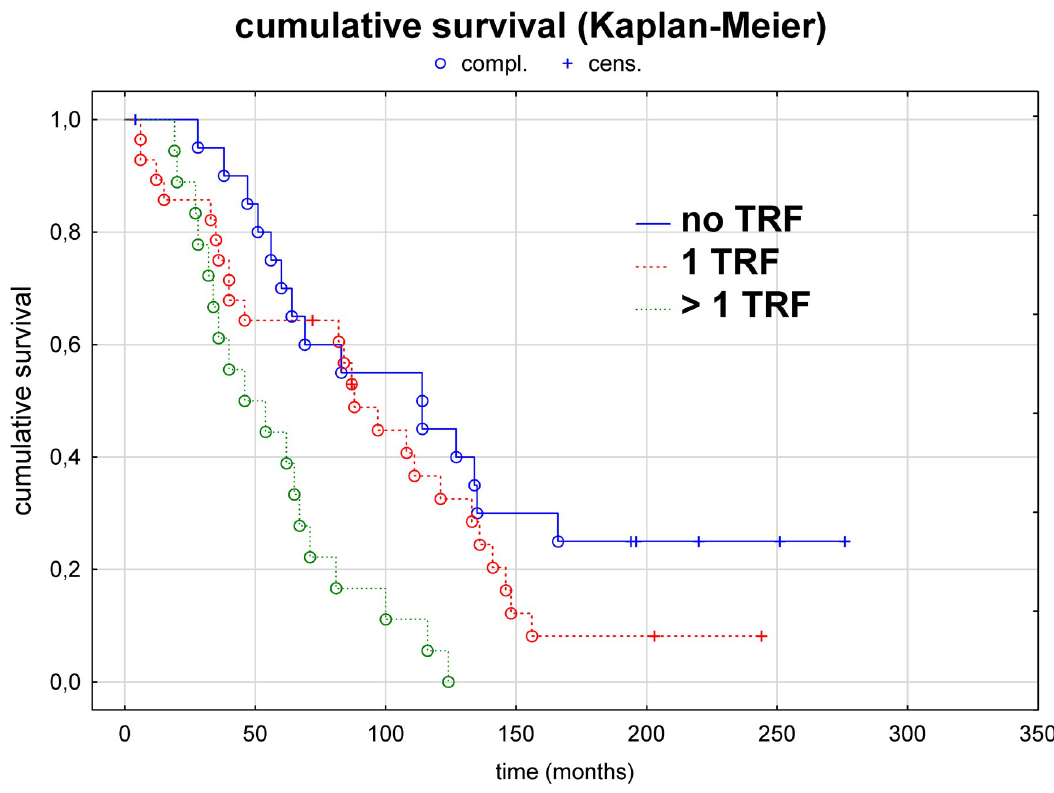
Fig 4. Survival analysis (Kaplan–Meier estimate and log-rank test) of patients with no thrombophilic risk factor (TRF) compared to patients with 1 TRF and patients with more than 1 TRF. Patient survival duration is significantly shorter in patients with more than 1 TRF than in patients without a TRF ( P < 0.01) or 1 TRF ( P < 0.02); however, the difference between the latter patients is not significant ( P = 0.175). Survival duration is significantly longer in patients without a TRF than in patients with a TRF ( P < 0.02; not